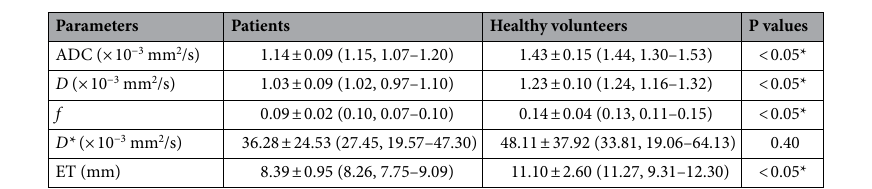
Table 2. Differences of IVIM parameters values and ET between patients and healthy women. Data are mean ± standard deviation (median, interquartile range). ADC apparent diffusion coefficient, D true